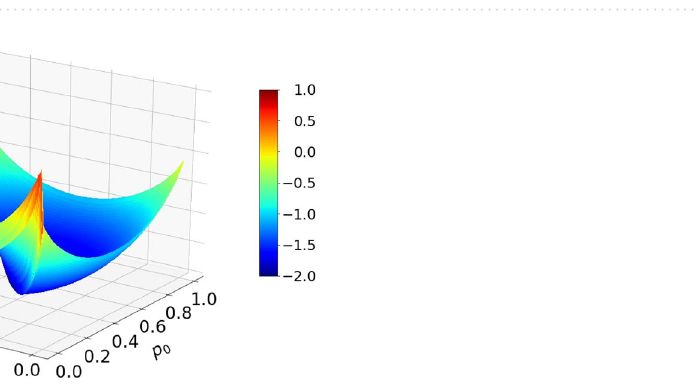
Figure 12. The transfer function (a) ; and errors from the ideal division calculation (b) for the circuit DIV3. N is the counter capacity in bits.